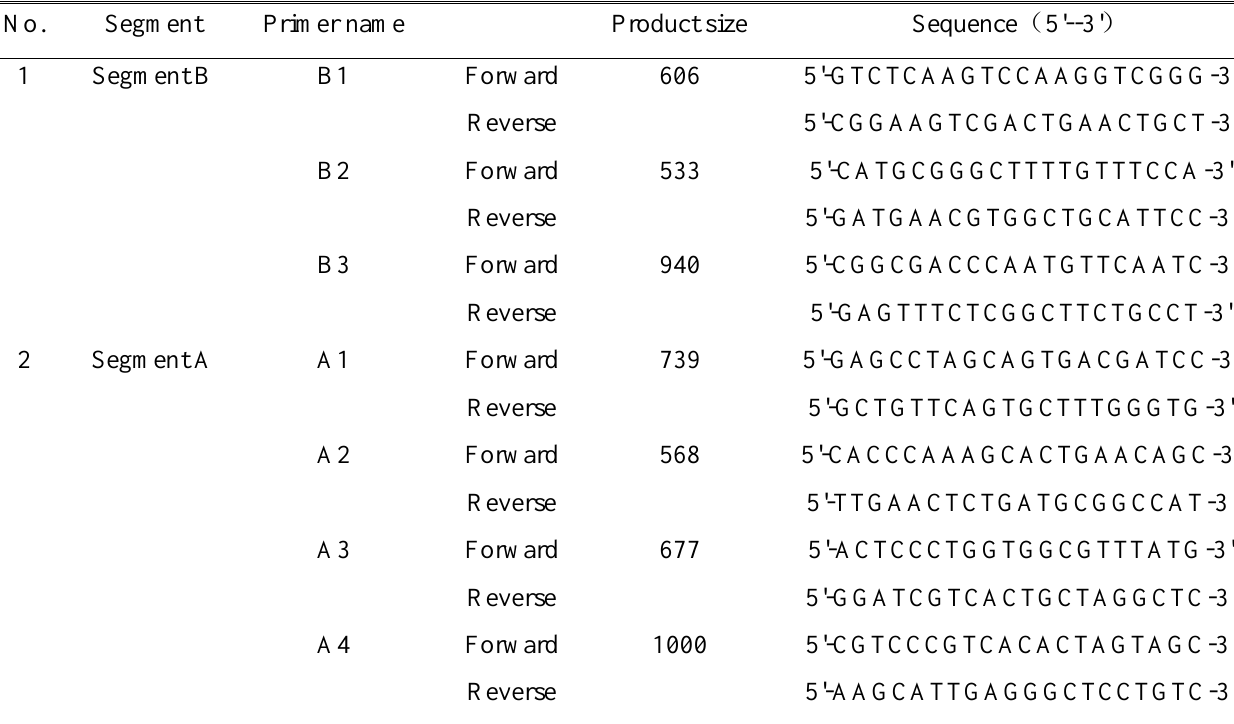
Table 1. Primers designed for VP 1, VP 2 genes and segment A and B of IBDV